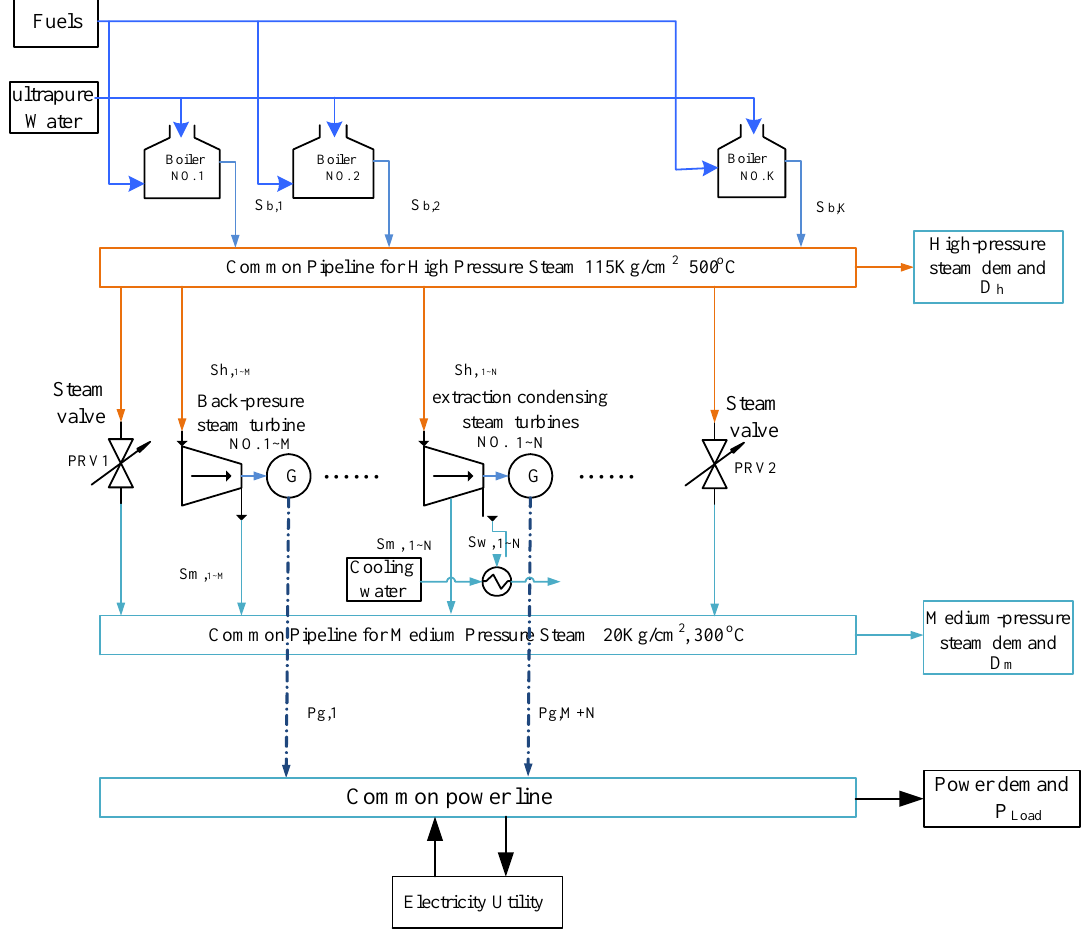
Figure 1. Energy flow of a cogeneration system.